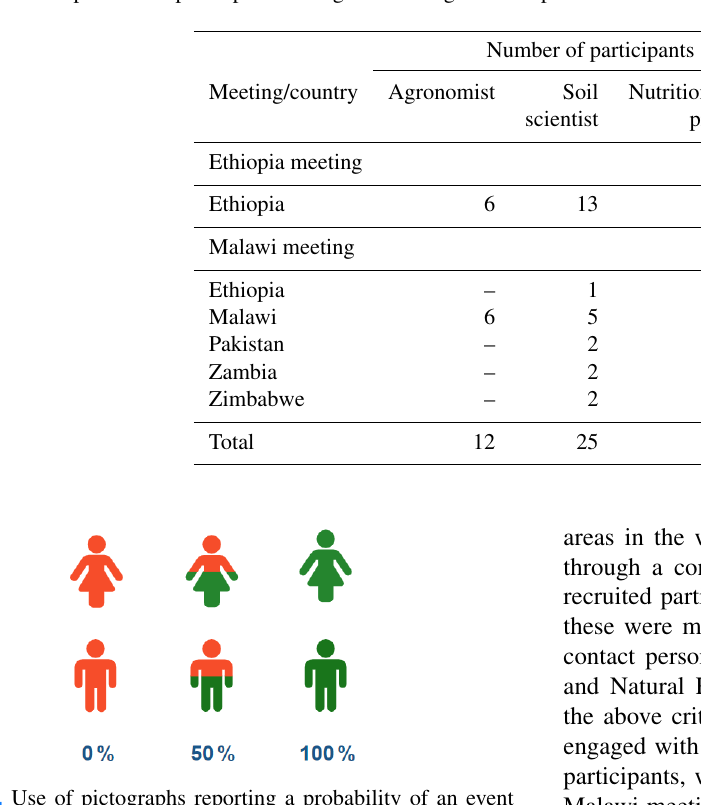
Table 2. The composition of participants during the meetings in Ethiopia and Malawi.